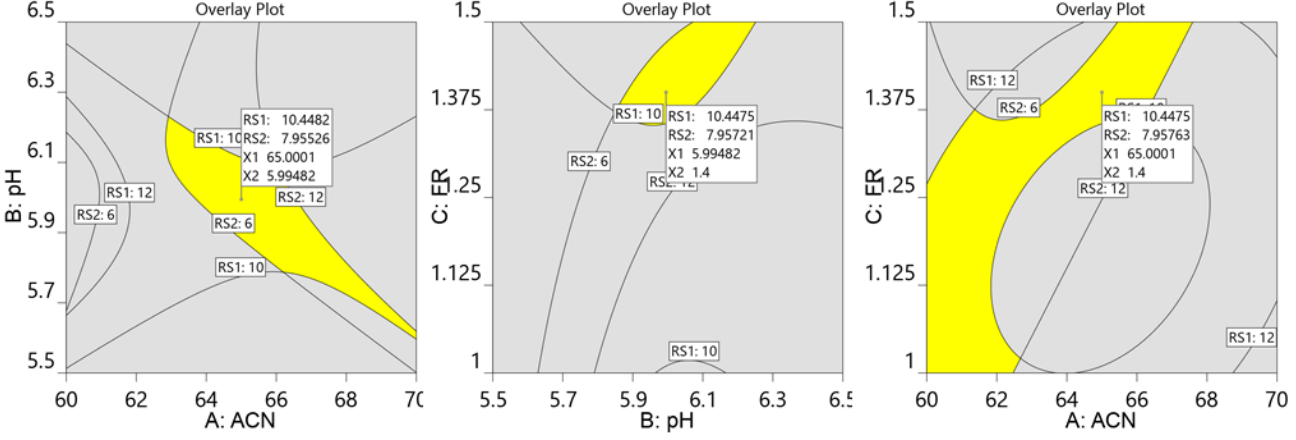
Figure 5. Overlay plot of chromatographic conditions suggested by the model. ACN: percentage acetonitrile; FR: flow rate.